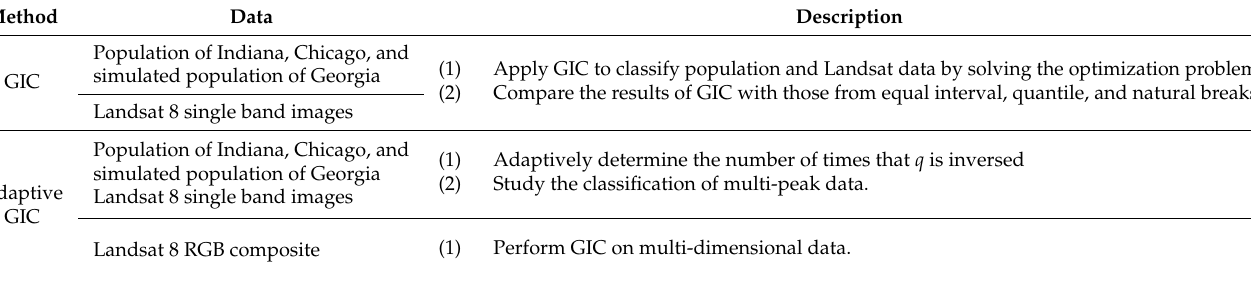
Table 1. Experimental settings.